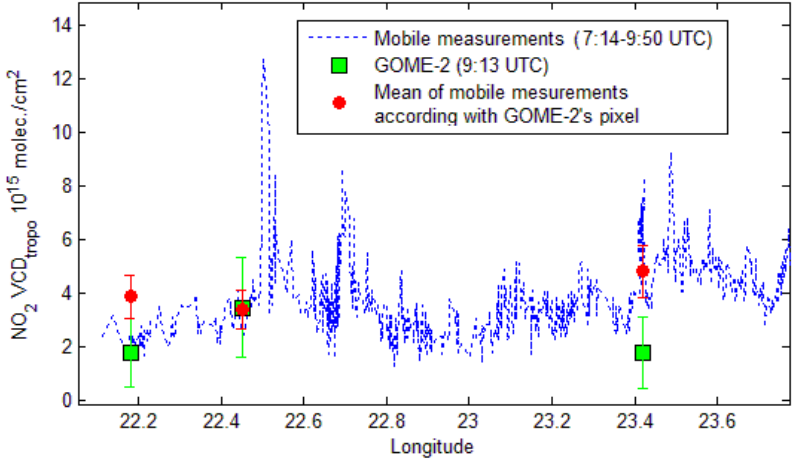
Figure 9. Comparison of tropospheric NO VCD obtained from mobile DOAS zenith-sky 2 measurements with GOME-2 observations (18 July 2011) and corresponding error bars.